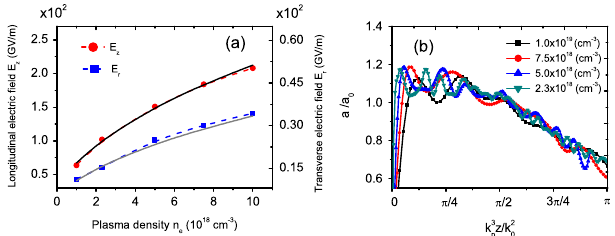
FIG. 2. Results of scaled simulation: (a) scaling of the peak and the transverse electric field E for accelerating electric field E z r various plasma densities. The normalized laser vector potential initially has a Gaussian form in the transverse direction and a ffiffiffi p ¼ ¼ 3 , and ! ¼ 1 : 7 . r (cid:5) 2 , k sin 2 temporal profile with a p L p L 0 The laser pulse propagates in a matched parabolic density channel ¼ 0 : 44 . The solid lines =n are (cid:1) n with the channel depth at r L c e show scaling calculated by Eq. (2) for the peak accelerating field ffiffiffi p ’ E = 3 E and the average transverse electric field E 2 given by z r z Eq. (15). (b) Evolution of the laser field a in terms of the initial ¼ z=k 2 as a function of the propagation distance k 3 laser field a p 0 0 Þ at various plasma densities. The stage length corre- k z ð n =n p e c ¼ (cid:1)= 2 and the effective dephasing length L =k 2 sponds to k 3 p stage 0 ¼ (cid:1) L =k 2 corresponds to k 3 dp p 0